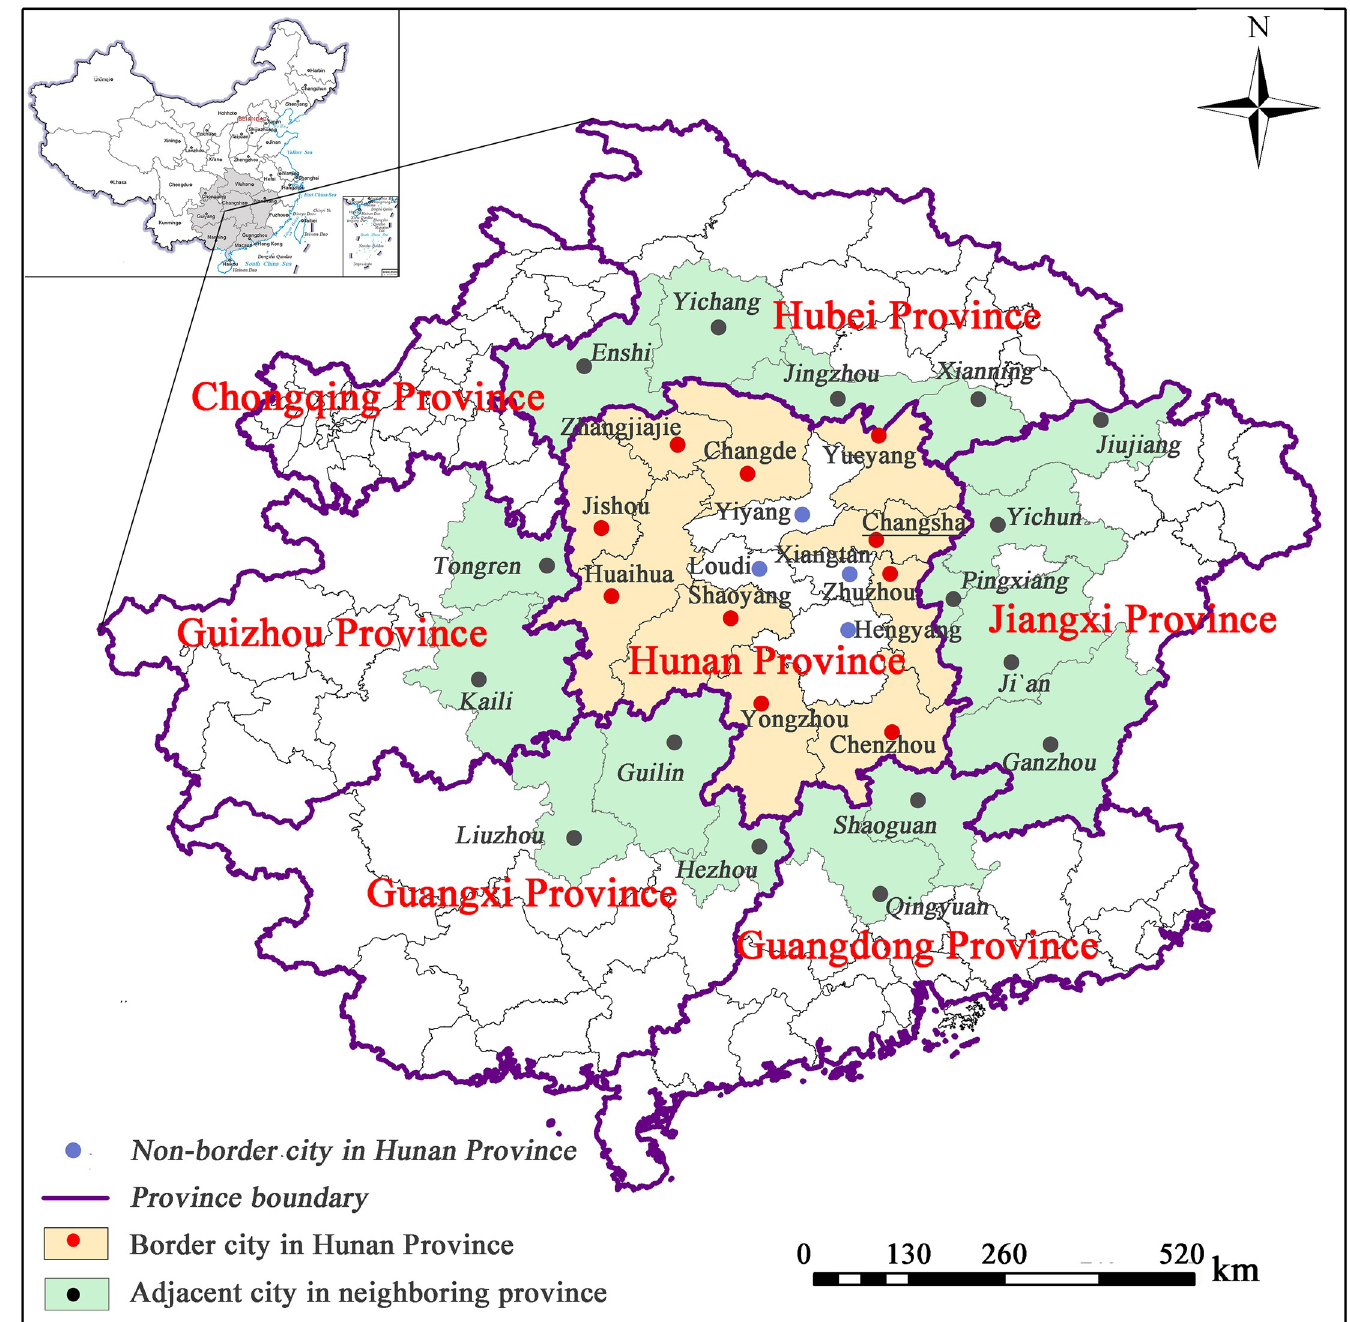
Fig 2. Distribution of cities in Hunan Province and its adjacent cities. (Reprinted from http://www.ngcc.cn/ngcc/ under a CC BY license, with permission from the National Geomatics Center of China , original copyright